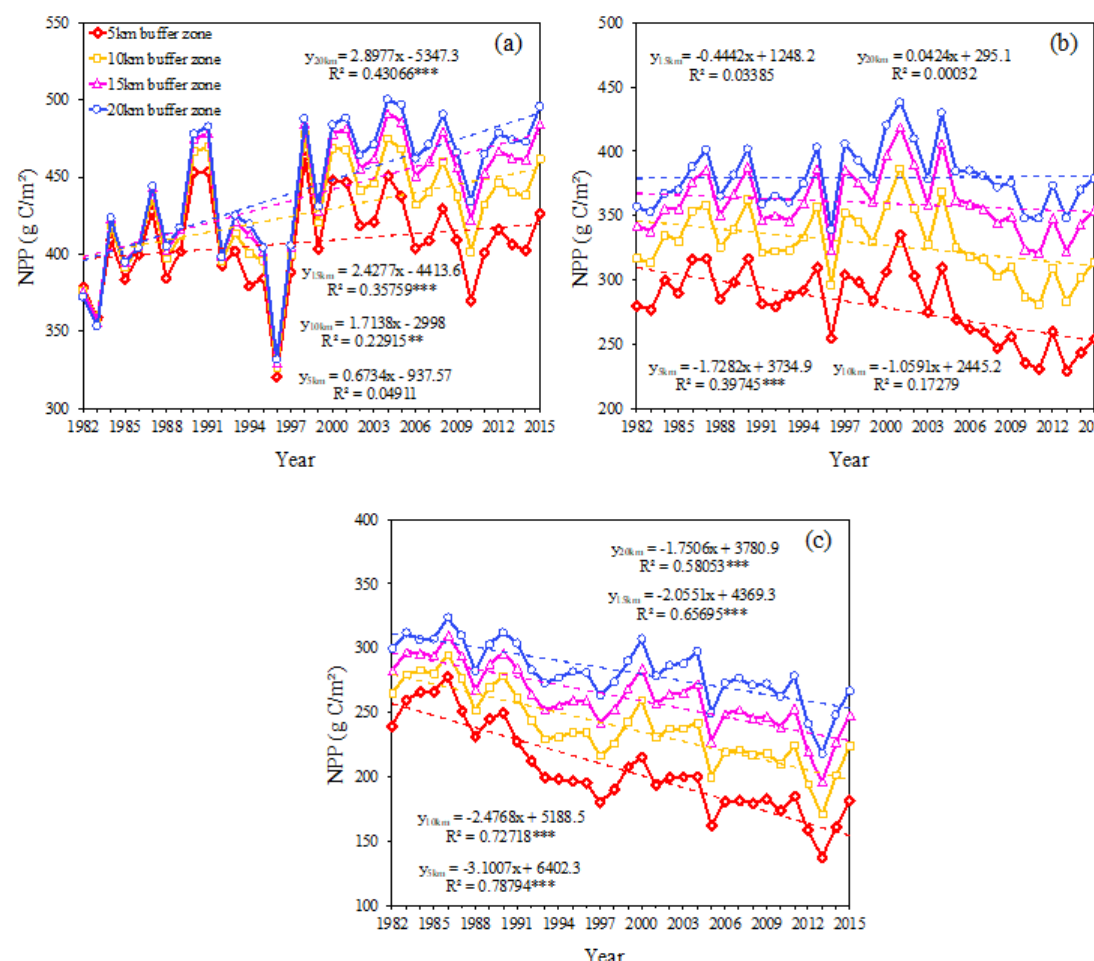
Figure 9. The NPP trends between 1982 and 2015 in the buffer zones (~5–20 km) of 2015 urban lands in ( a ) the BTHUA, ( b ) the YRDUA, and ( c ) the PRDUA. The mark (***) indicates a relative level of significance where p < 0.001, and the mark (**) indicates a relative level of significance where p <